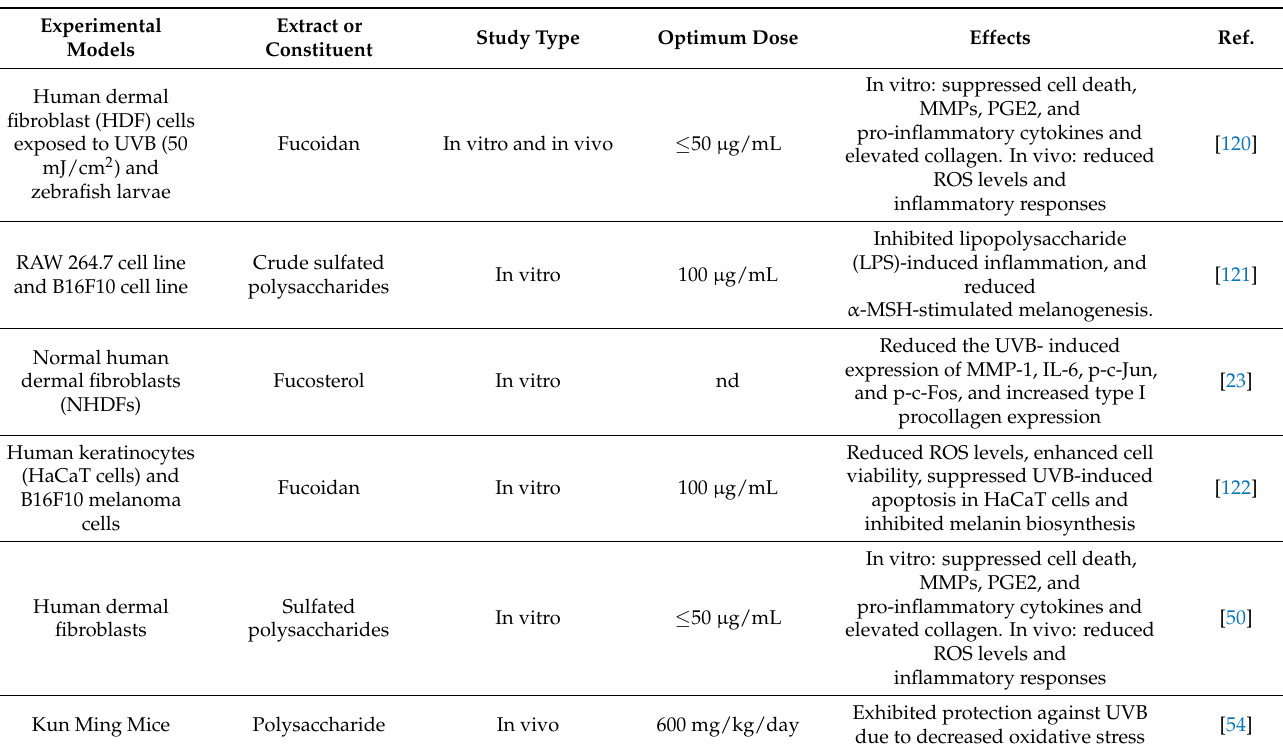
Table 9. Summary of photoprotective activity of H. fusiformis